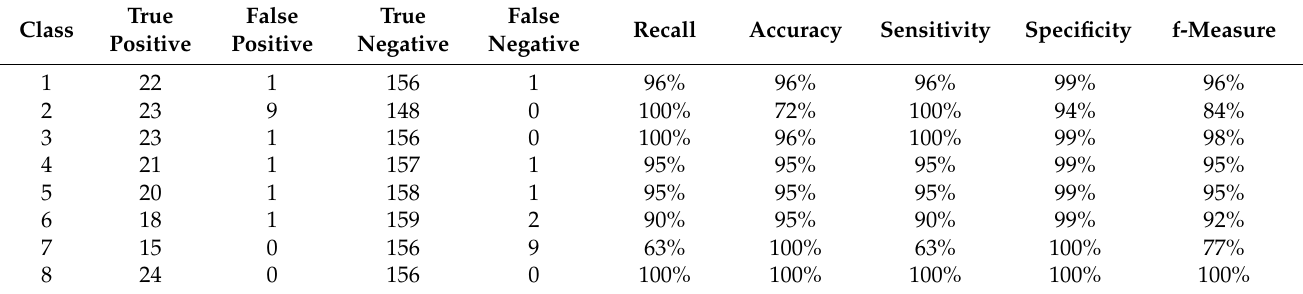
Table 7. Results of classification of eight investigated classes of PDs using PNN